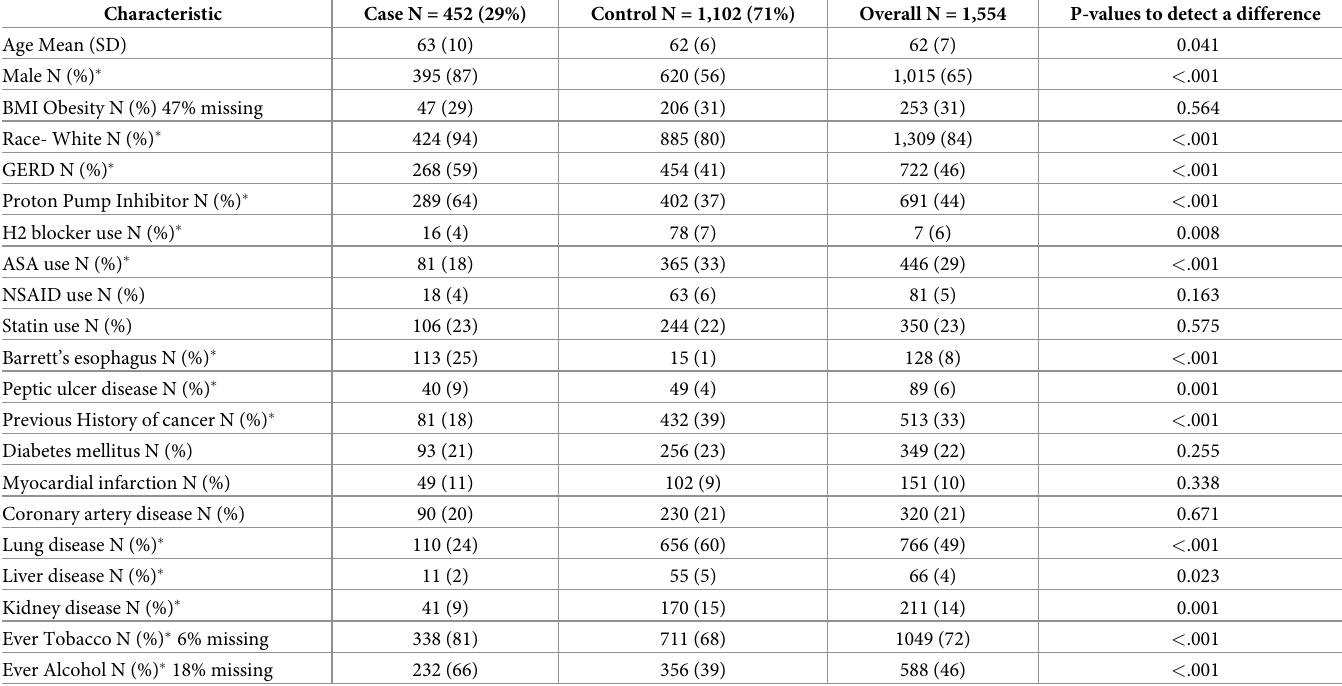
Table 1. Baseline characteristics and medical history for HGD/EAC cases and thoracic surgery controls. Characteristic